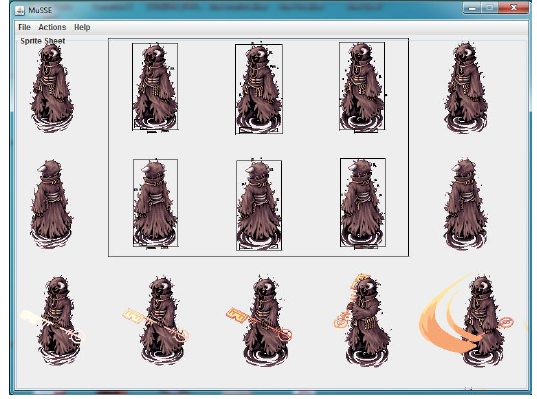
Fig. 18. Sprite sheet with low connectivity. Source: MuSSE with sprite sheet image from the game Ragnarok Online©. Fig. 19 shows a close-up from Fig. 18. The sprite sheet used for this example has sprites with low connectivity. In other words, sprites with detached parts from the “main body”. As described in Section III, that particularity causes the smaller – disconnected parts – to be mapped as new blobs: